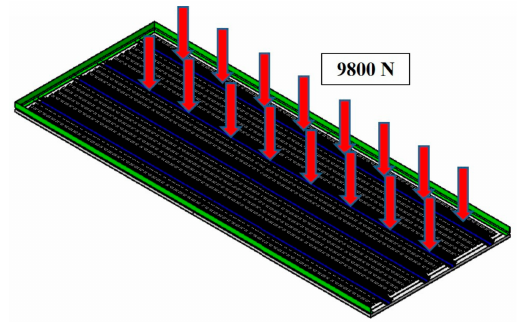
Figure 12. Load case 2 for structural analysis.